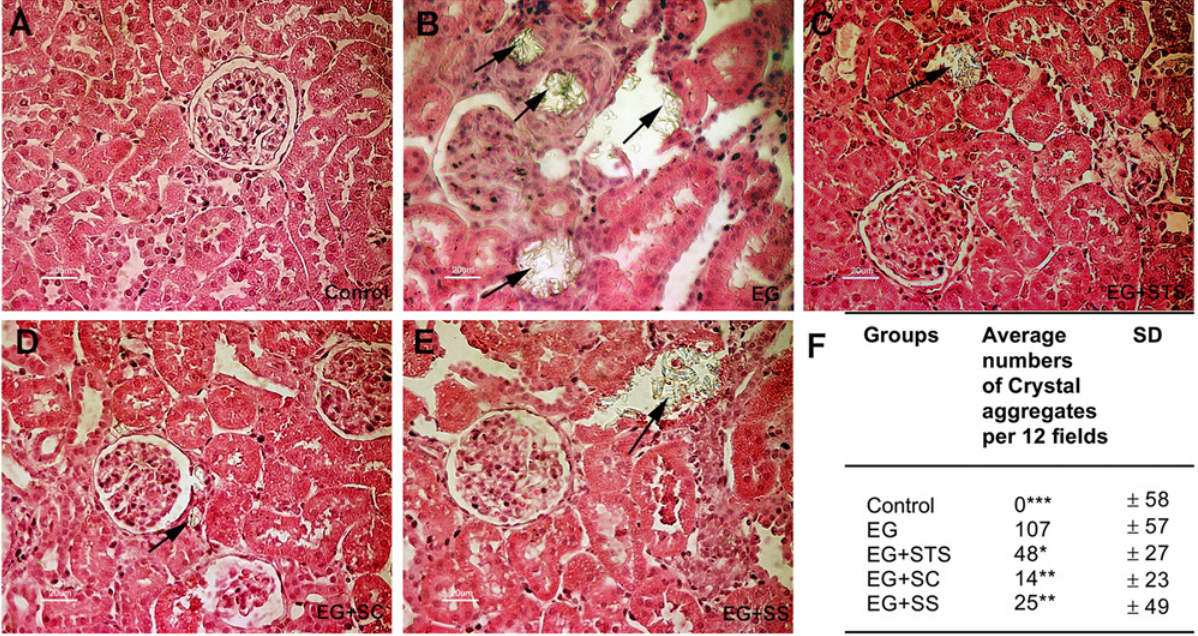
Fig 2. EG-induced changes of kidney histology. Representative hematoxylin- and eosin-stained kidney sections obtained from (A) control, (B) EG- exposed, (C) EG+STS-exposed, (D) EG+SC-exposed, (E) EG+SS-exposed animal groups. Arrows indicate calcium oxalate crystal deposits. (F) Results of light microscopic quantification of crystal aggregates. The data are means ± SD from 7 – 8 animals per group. The significance levels are with reference to the EG group. * p < 0.05, ** p < 0.01, *** p <